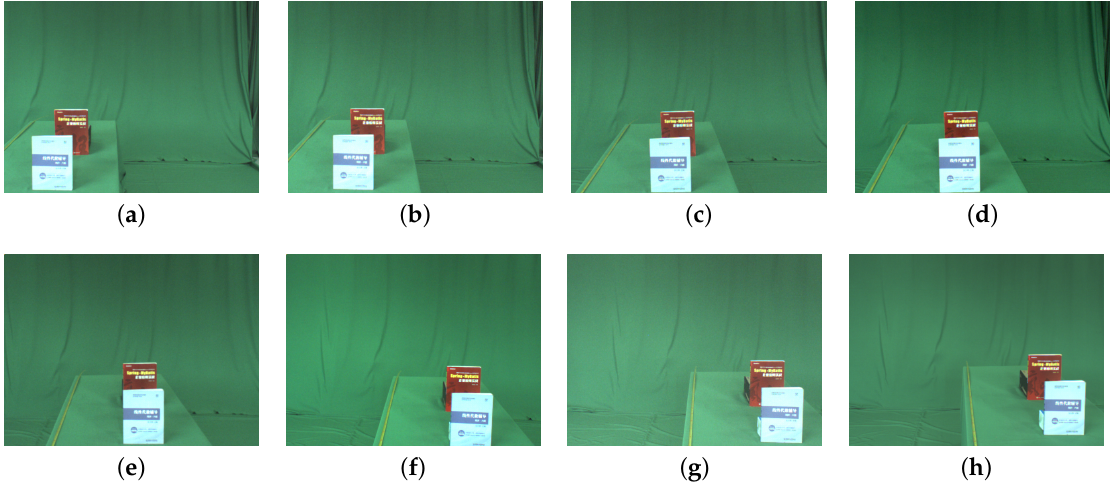
Figure 6. Examples of input book images. ( a – h ) are captured images by camera array in the same scene. Firstly, we used Equations (3), (4), (6) and (7) to generate the synthetic aperture images focusing on the front book. The region of the front book was clear, and the other region was blurry. Pixels of the front book were labeled with the variance method in Equation (8). We have also obtained the images